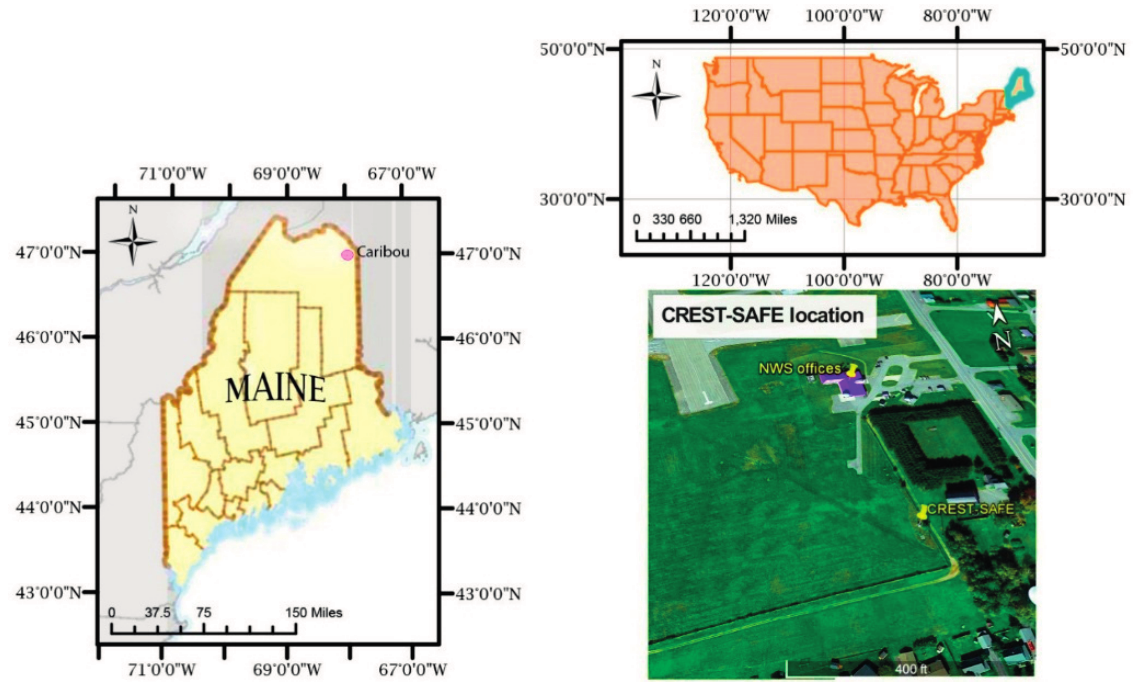
Figure 1. CREST-SAFE